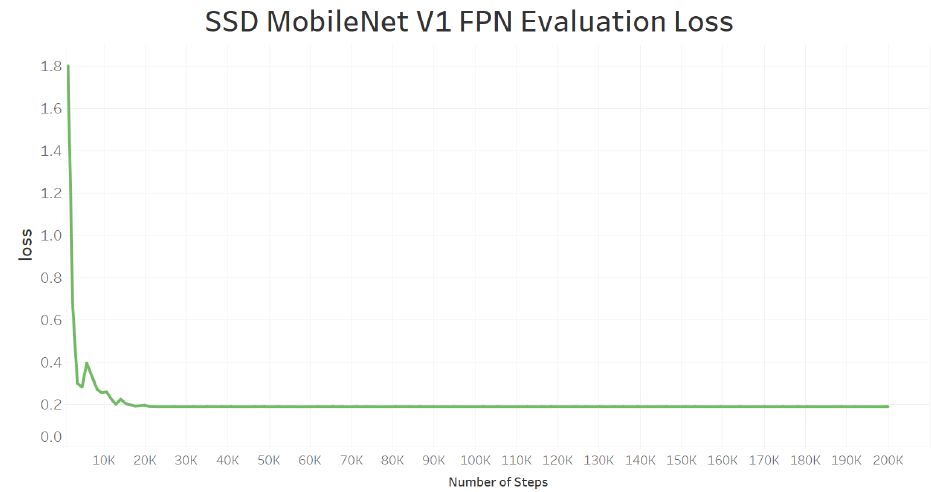
Figure 17. The SSDV1Lite model has an evaluation loss of around 0.2. This model also does not have an over-fitting